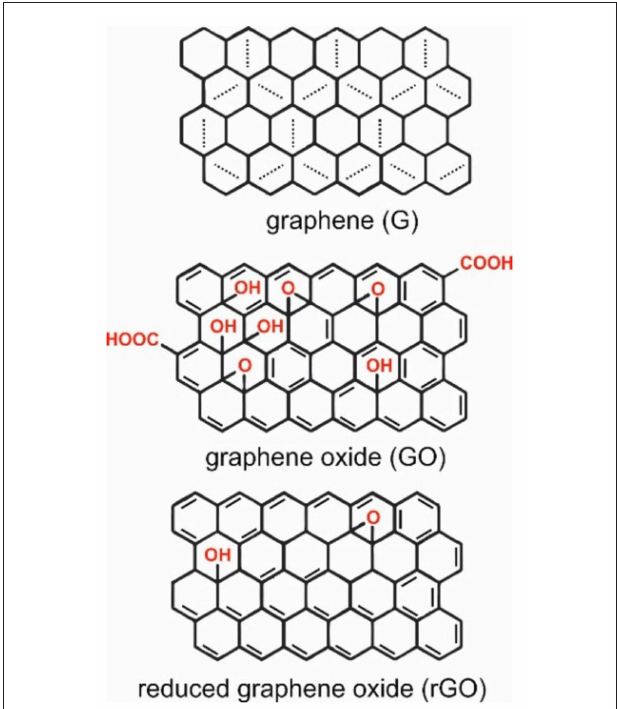
FIGURE 2 | Structures of garaphene (G), graphene oxide (GO), and reduced graphene oxide (rGO). Reproduced with permission from Tadyszak et al.